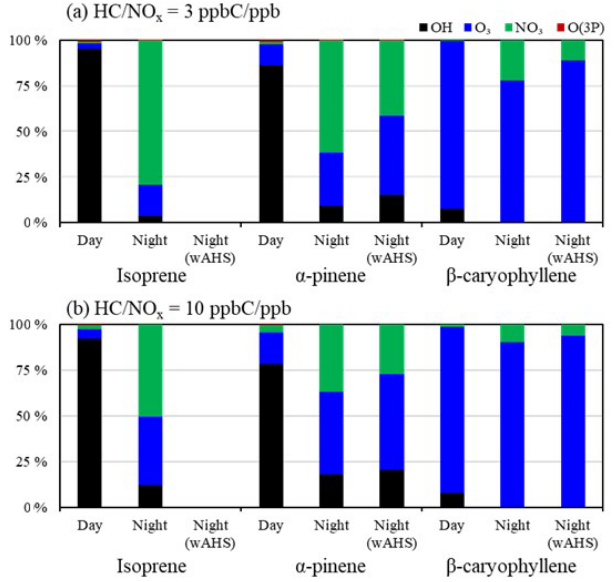
Figure 7. The contribution of each oxidation path to the consumption of isoprene, α -pinene, and β - caryophyllene under the given condition under three dif- ferent NO x levels ( a HC / NO x = 3ppbCppb − 1 and (b) HC / NO x = 10ppbCppb − 1 ). The gas oxidation in day- time was simulated under the reference sunlight intensity, which was measured on 19 June 2015 (Fig.